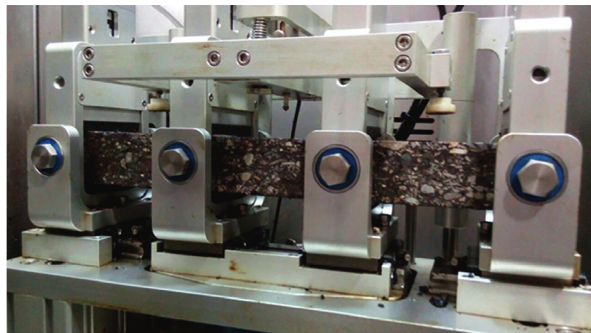
Figure 4: Four-point bending beam fatigue test